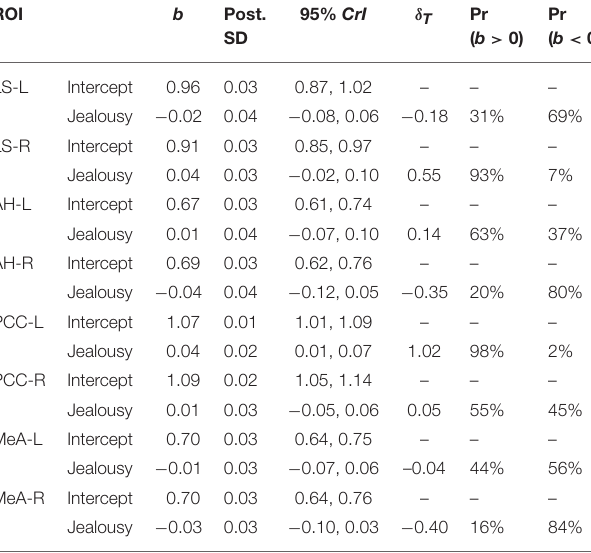
95% CrI δ T Pr Pr SD ( b > 0) ( b < 0)